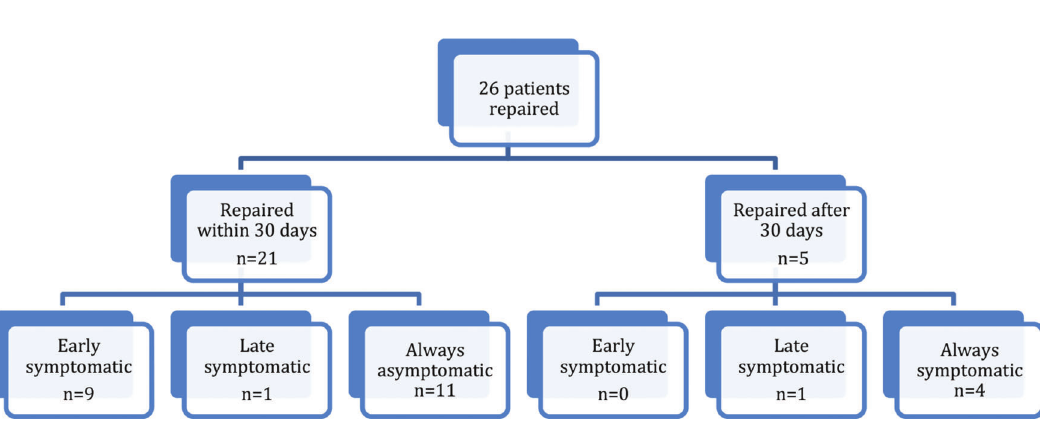
Figure 2 - Flowchart of patients who underwent aneurysm repair by symptom